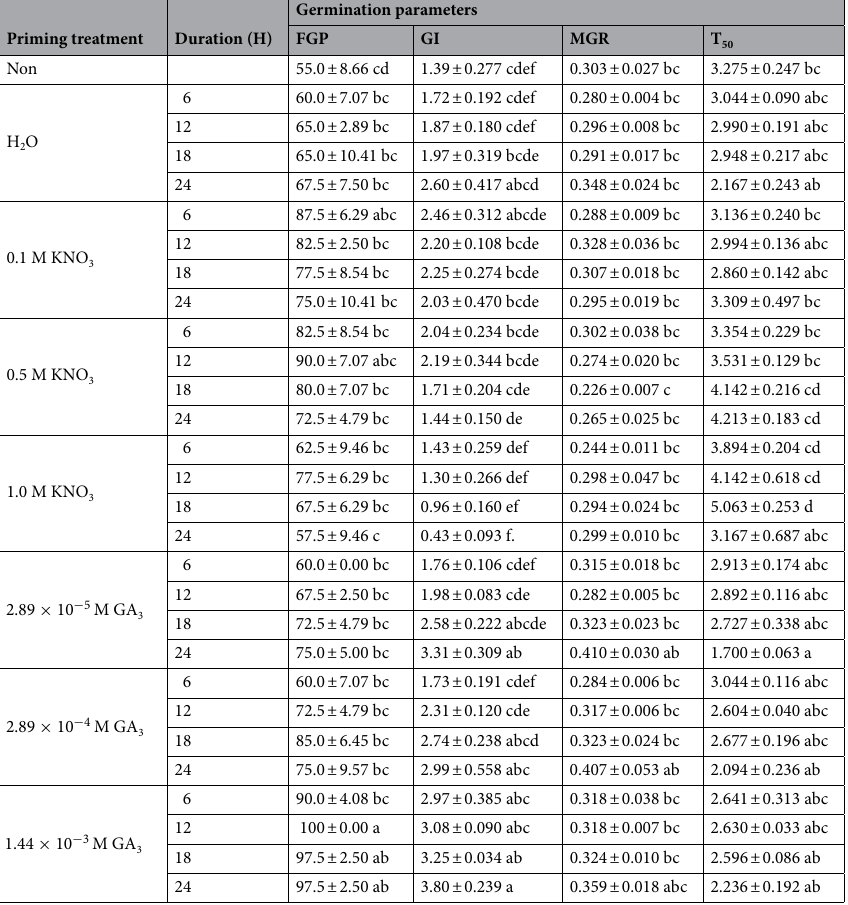
Table 1. Effects of different priming treatments and durations on in vitro germination of Aspilia africana. Means (± standard error) within a column followed by same letters are not significantly different using Tukey’s multiple comparison test and p = 0.05. FGP is final germination percentage, GI is germination index, MGR is mean germination rate, T 50 is time to 50%